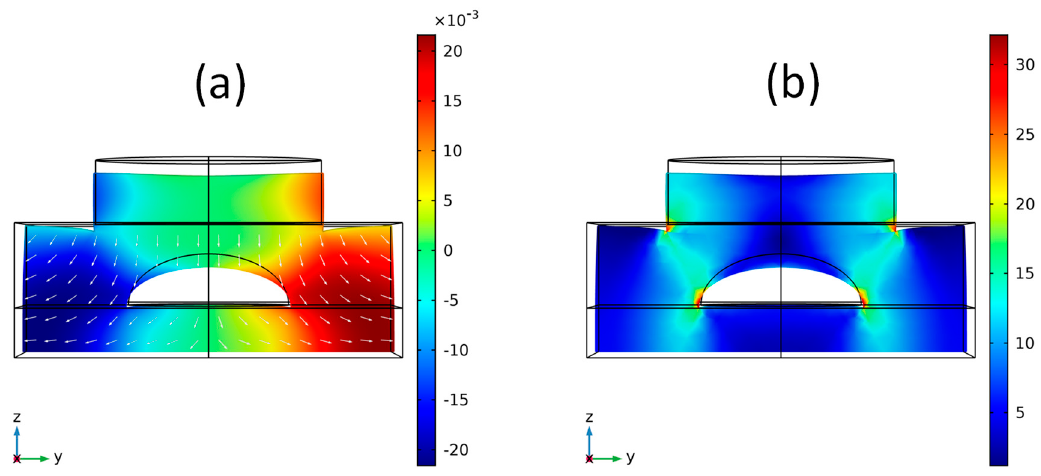
Figure 5. Surface graphics resulting from COMSOL simulation for PEEK sensor. ( a ) Deformation surface graph (mm) and ( b ) Von Mises stress graph (MPa).